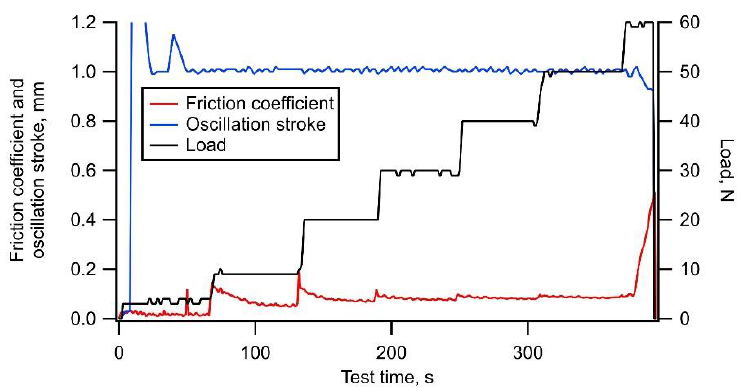
Figure 7. Typical example of trends of friction coefficient, oscillation stroke, and load during test using ta-C film.